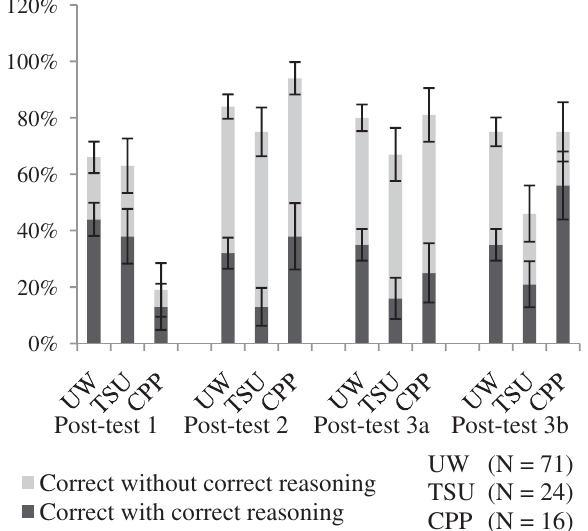
FIG. 8. Student performance on all four post-test questions at three different universities. Error bars represent the standard